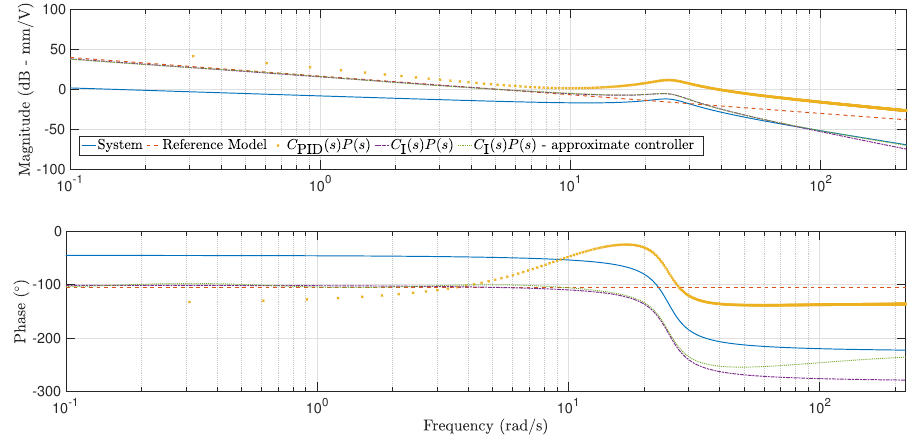
Figure 10. Frequency response of the reference model and the controlled system in